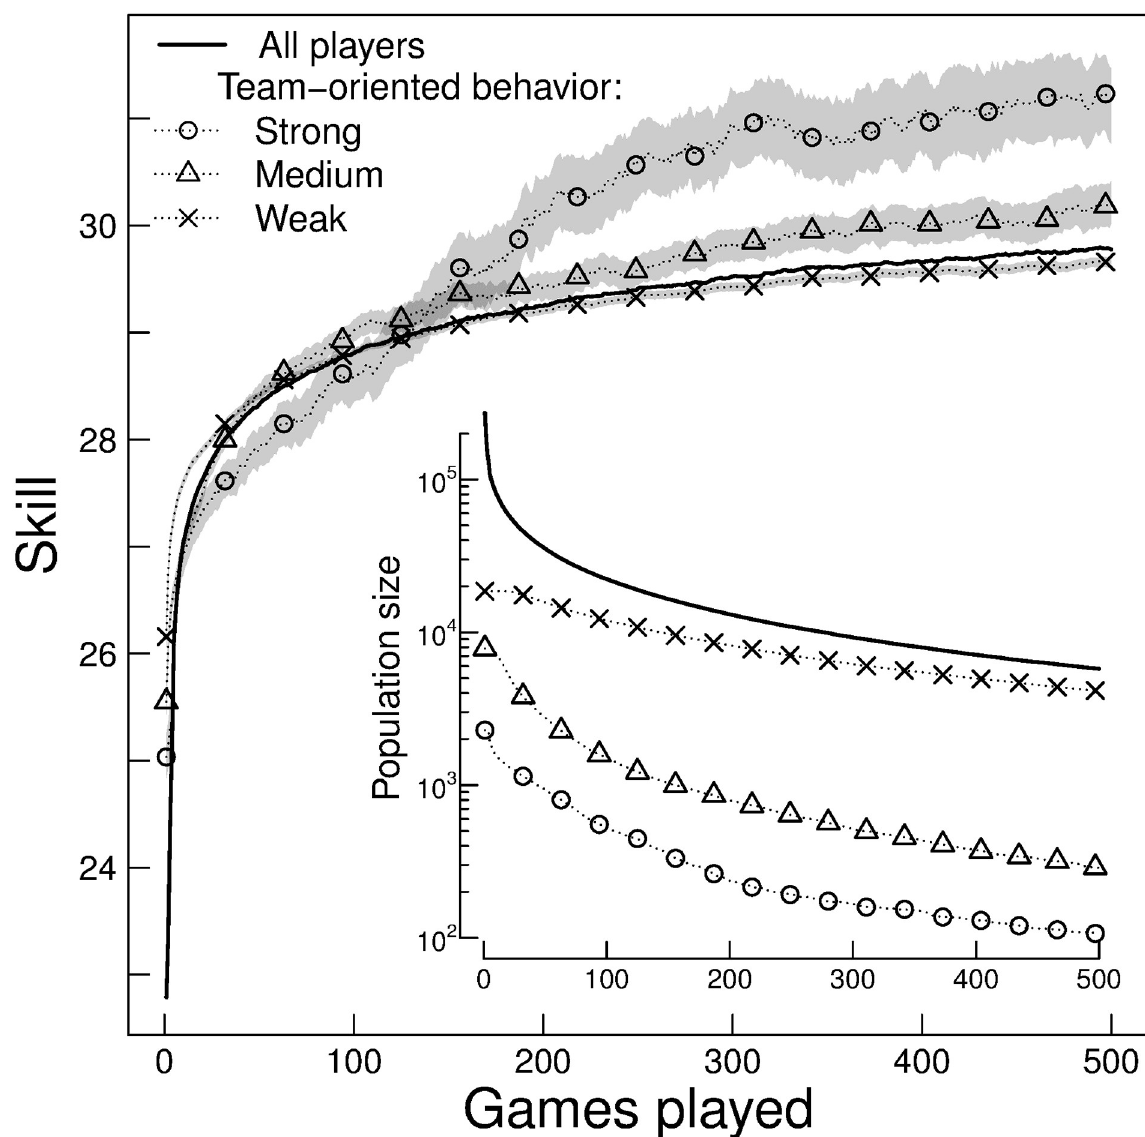
Fig 2. Social learning. The learning curve for strong, medium and weak team-oriented behavior. The band represents 95% Wilcoxon rank-sum confident interval, and the middle line represents the pseudomedian. As a reference, we show the learning curve of the whole population. Results are analogous to those obtained with mean and 95% t-test confident